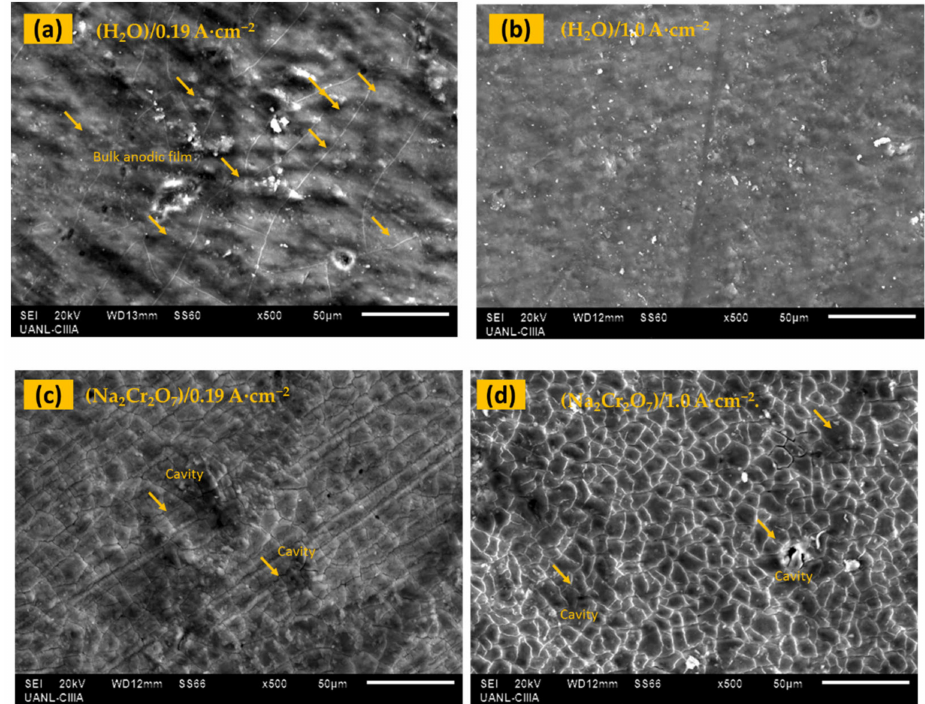
Figure 1. SEM-SEI surface micrographs of the anodized AA2055 alloys with different sealing treat- ments: ( a ) S1, ( b ) S2, ( c ) S3, and ( d )